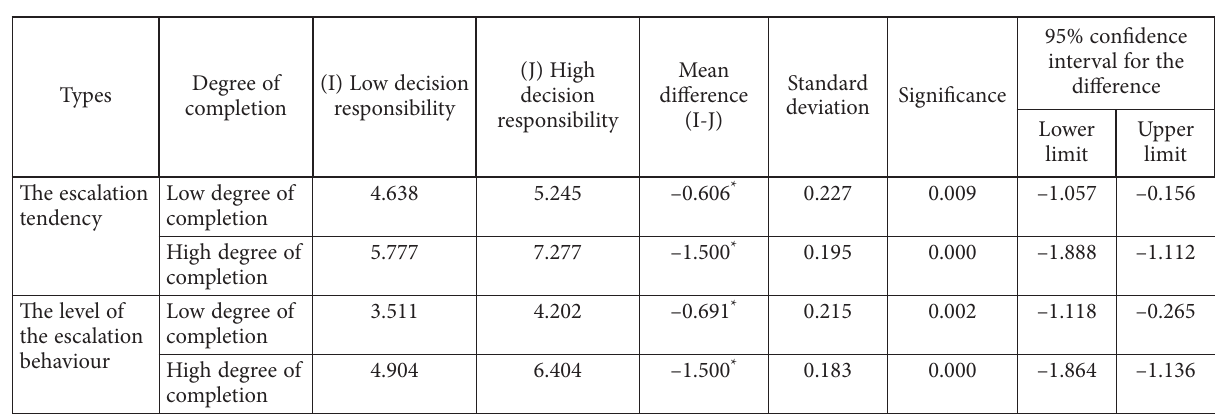
Table 4. EOC of investors in PPP projects: comparison in pairs